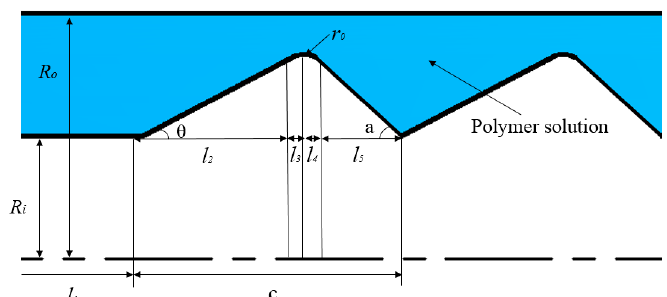
Figure 5. Representation of the throttling section flow channel. R 0 is the radius of the outer cylinder; R i is the radius of the inner cylinder; l 1 is the length of the annular flow channel; l 2 is the length of the contraction part of the single throttling section; l 3 is the length of the intermediate constricting part of the single throttling section; l 4 is the length of the intermediate expansion section of the single throttling section; l 5 is the length of the expansion section of the single throttling section; c is the total length of the single throttling section; r o is the radius of the intermediate arc; θ is the front groove angle of the single throttling section—it is the convex angle of the contraction section relative to the horizontal section; and α is the rear groove angle of the single throttling section—it is the convex angle of the expansion section relative to the horizontal section. Table 3. Structural parameters of the throttling section.